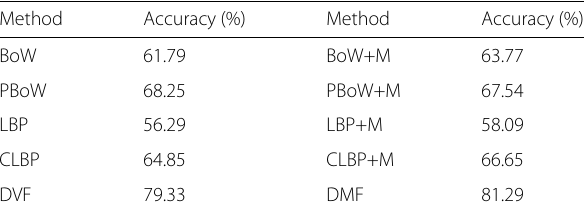
Table 5 Classification accuracy (%) with 1NN classifier for different methods Method